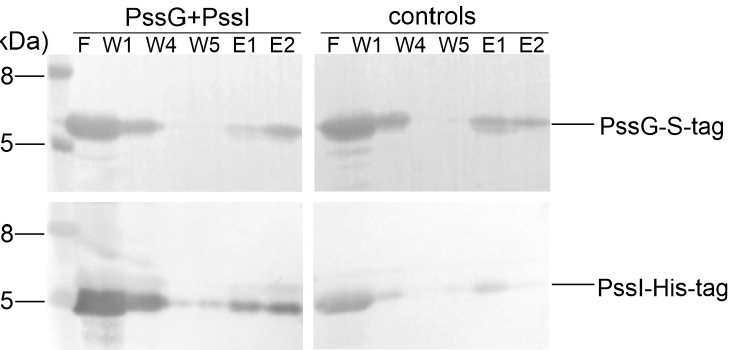
Figure 8. Pull ‐ down verification of the PssG ‐ PssI interaction revealed in a two ‐ hybrid screening. PssG ‐ S ‐ tag (100 μ g) and PssI ‐ His6 (100 μ g) proteins were mixed and applied to the S ‐ tag affinity resin. After several rounds of washing (W1–W5), proteins were eluted from the resin and fraction composition was examined using Western blot with anti ‐ His 6 and anti ‐ S ‐ tag antibodies. Controls of the experiment were PssG ‐ S ‐ tag and PssI ‐ His6, which were applied to the resin alone. F, flow; W, wash; E, elution. Top blots: detection with anti ‐ S ‐ tag antibodies; bottom blots: detection with anti ‐ His 6 antibodies.